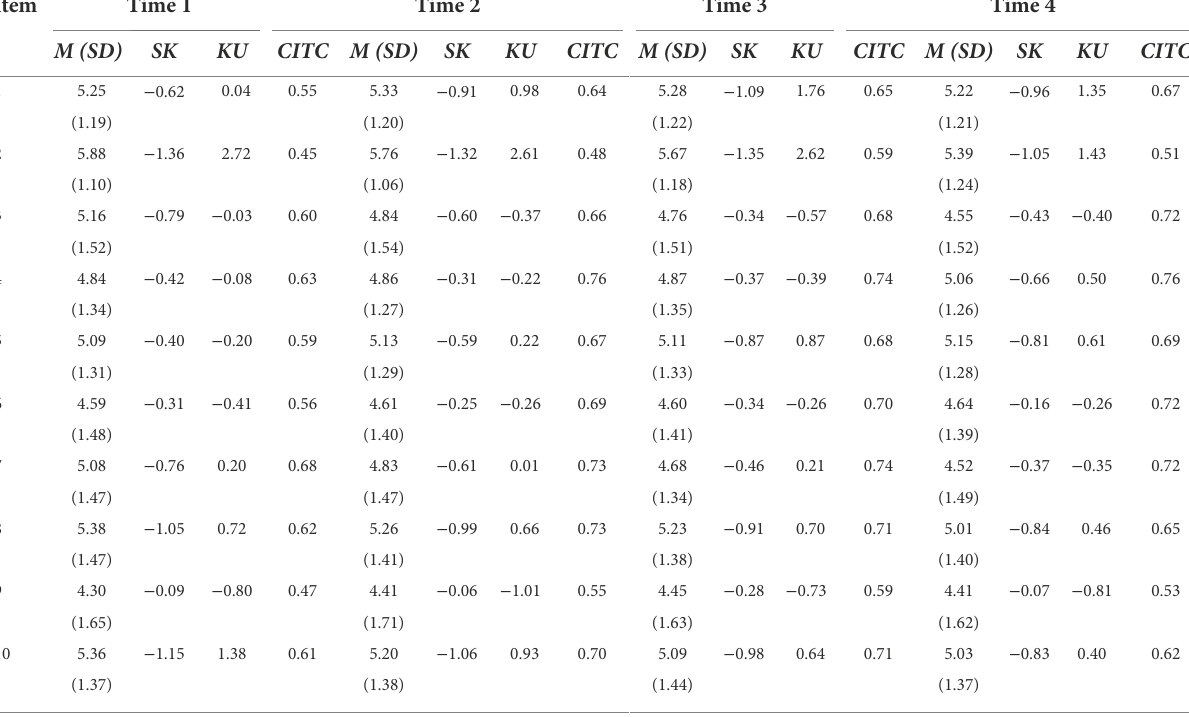
TABLE 2 Descriptive statistics for the MLQ scores over